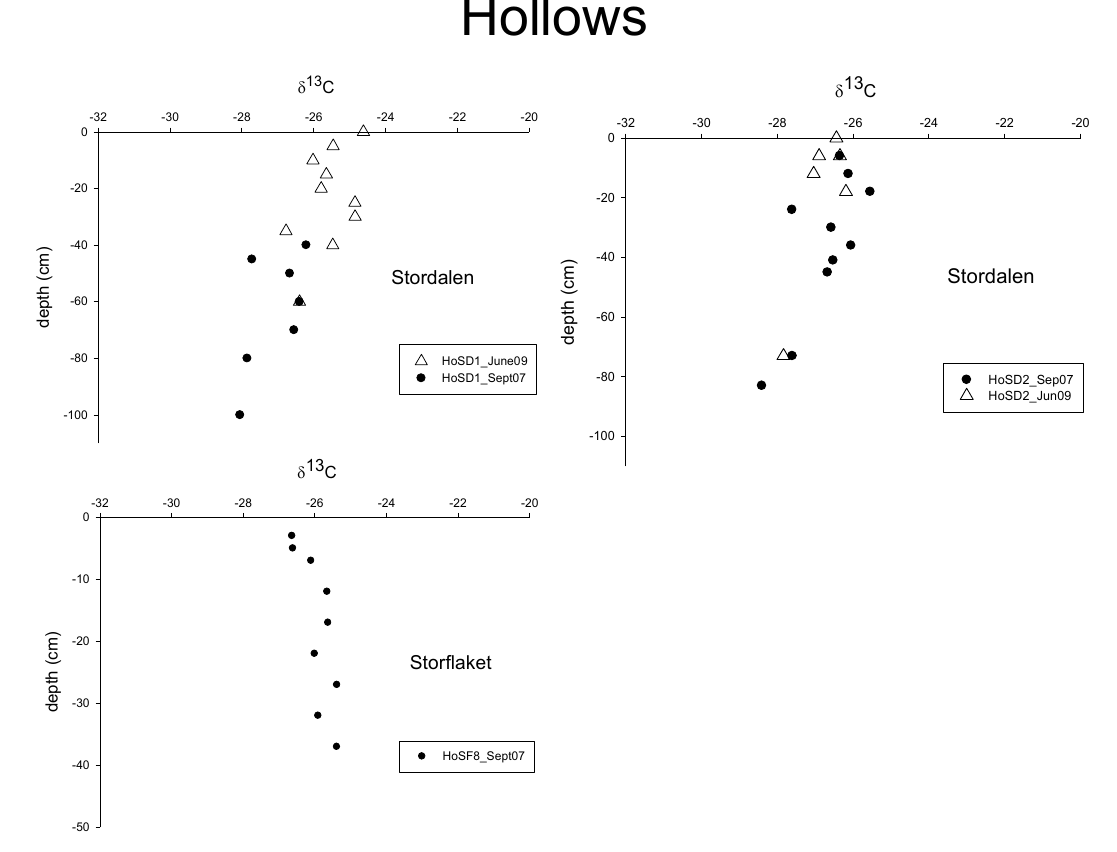
Fig. 4. Isotope depth profiles of the investigated hollows. δ 13 C in ‰.